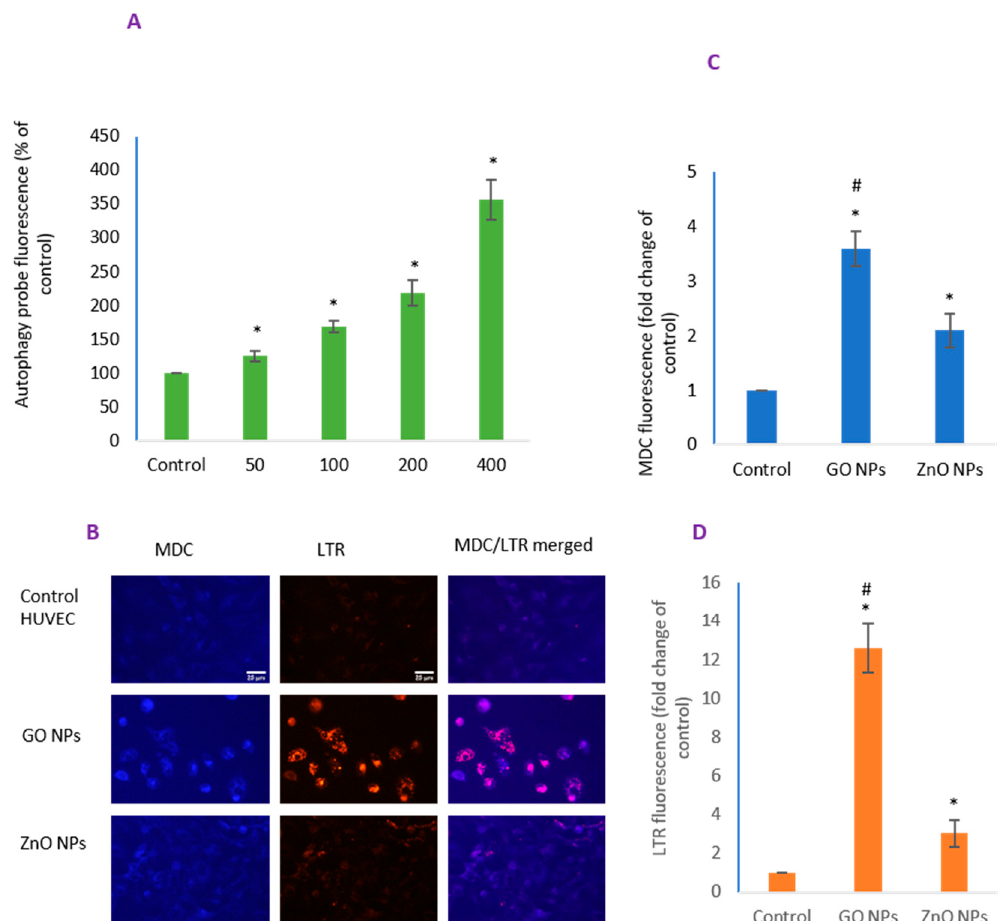
Figure 5. Autophagy was determined by a ( A ) plate reader as well as by ( B ) direct observation under microscopy. Merging of images was carried out in ImageJ software; ( C , D ) CTCF for monodansylcadaverine (MDC) and LysoTracker (LTR), respectively. Scale bar represents 25 µm (40× objective). * Statistically significant difference than the controls ( p < 0.05). #—Significantly high MDC and LTR activity due to GO NPs compared to ZnO NPs ( p < 0.05).